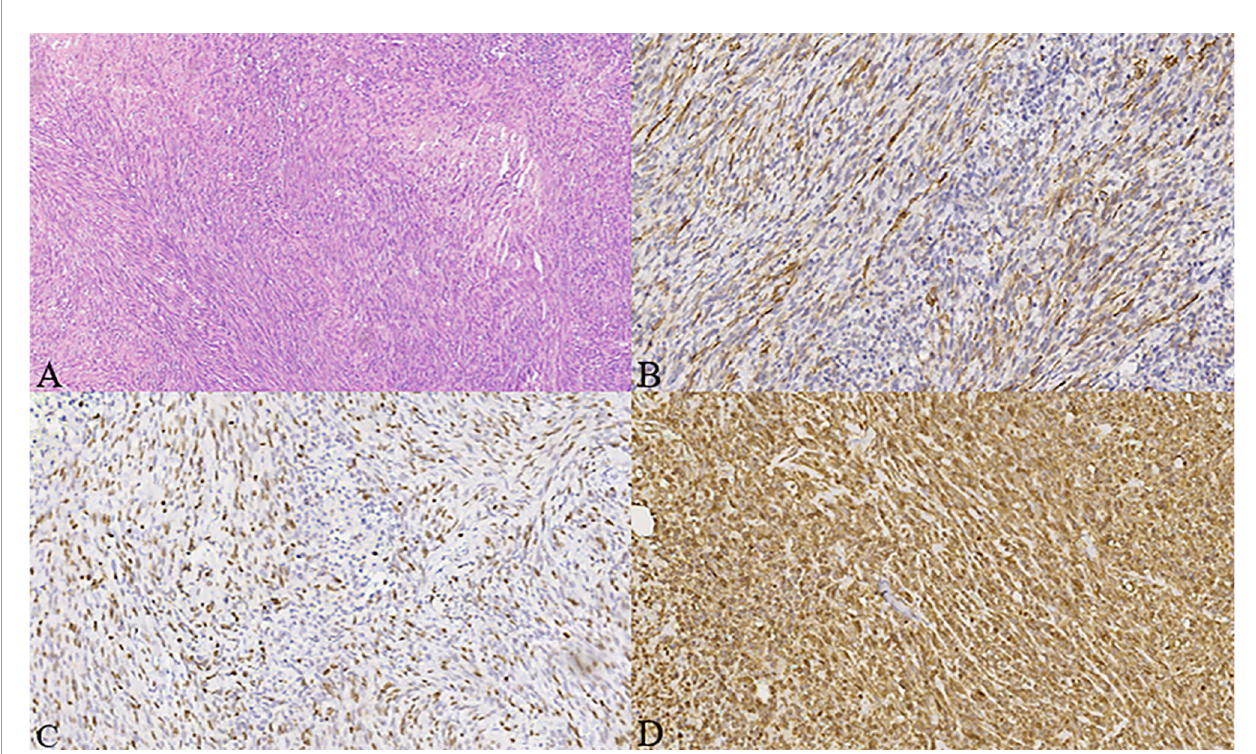
FIGURE 4 | (A – D) Histologic, immunohistochemical staining of in fl ammatory myo fi broblastic tumor (IMT). The mass showed spindle cells admixed with in fl ammatory cells (H&E stain, × 100) (A) . Immunohistochemical staining showed positive staining for smooth muscle actin (SMA) in the spindle tumor cells (SMA, × 200) (B) , positive staining for Ki-67 in about 30% of the spindle tumor cells (Ki-67, × 200) (C) , as well as positive staining for vimentin in the spindle tumor cells (vimentin, × 200) (D)